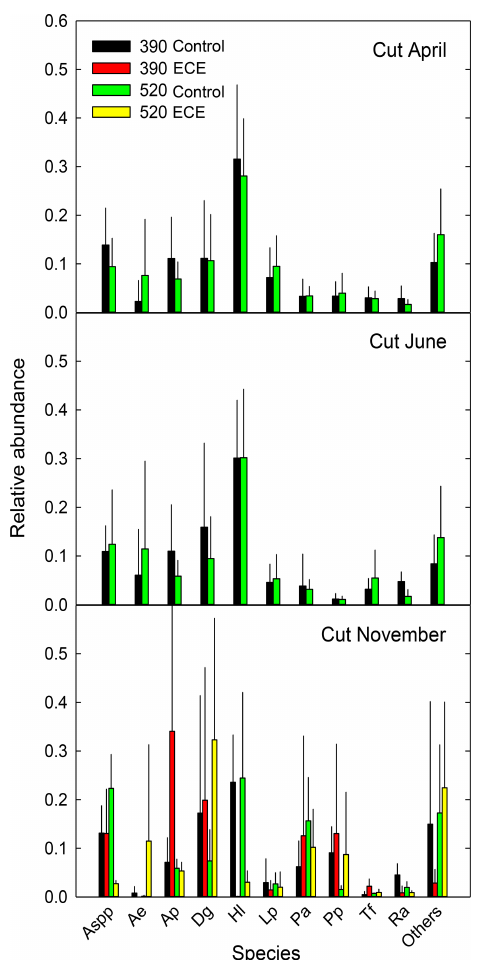
Figure 3. Relative abundance of the 10 most abundant species present in the community measured before (April, June) and af- ter (November) the extreme climatic event (ECE) grown under four climate scenarios: 390 or 520ppm atmospheric CO 2 concentration without (control) or combined with the ECE. Aspp: Agrostis spp.; Ae: Arrhenatherum elatius L.; Ap: Alopecurus pratensis L.; Dg: Dactylis glomerata L.; Hl: Holcus lanatus L.; Lp: Lolium perenne L.; Pa: Poa angustifolia L.; Pp: Poa pratensis L.; Tf: Trisetum flavescens L.; Ra: Rumex acetosa L.; Others: < 15% of species; n =